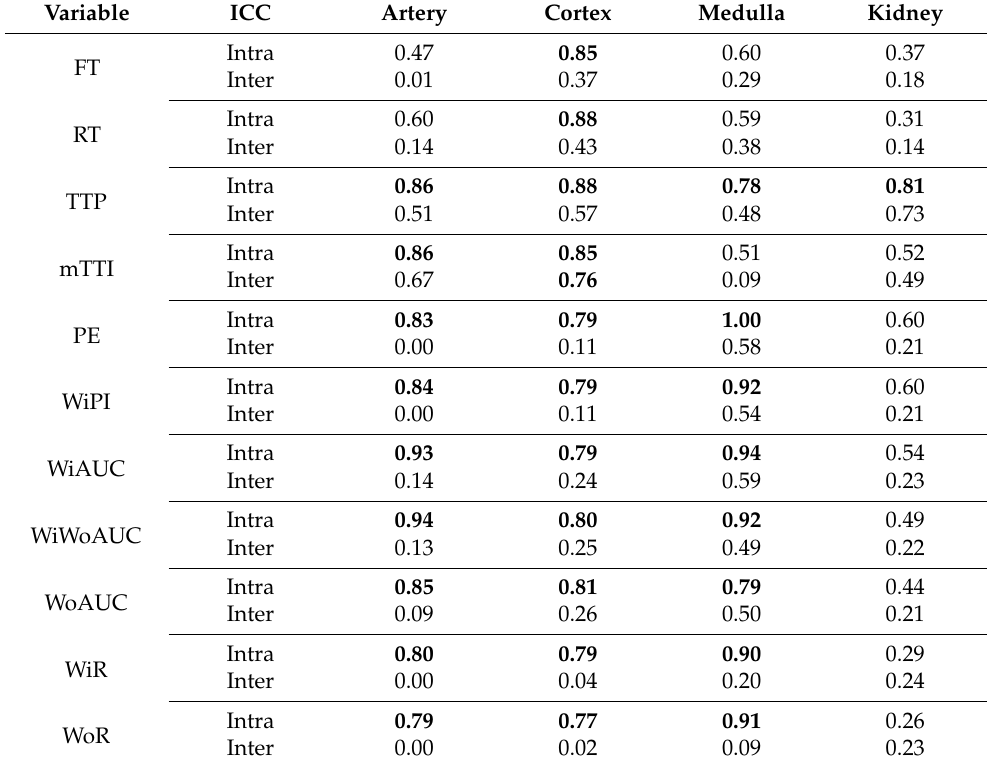
Table 2. Mean intra- and inter-period agreement for measurement of contrast-enhanced renal perfusion parameters.